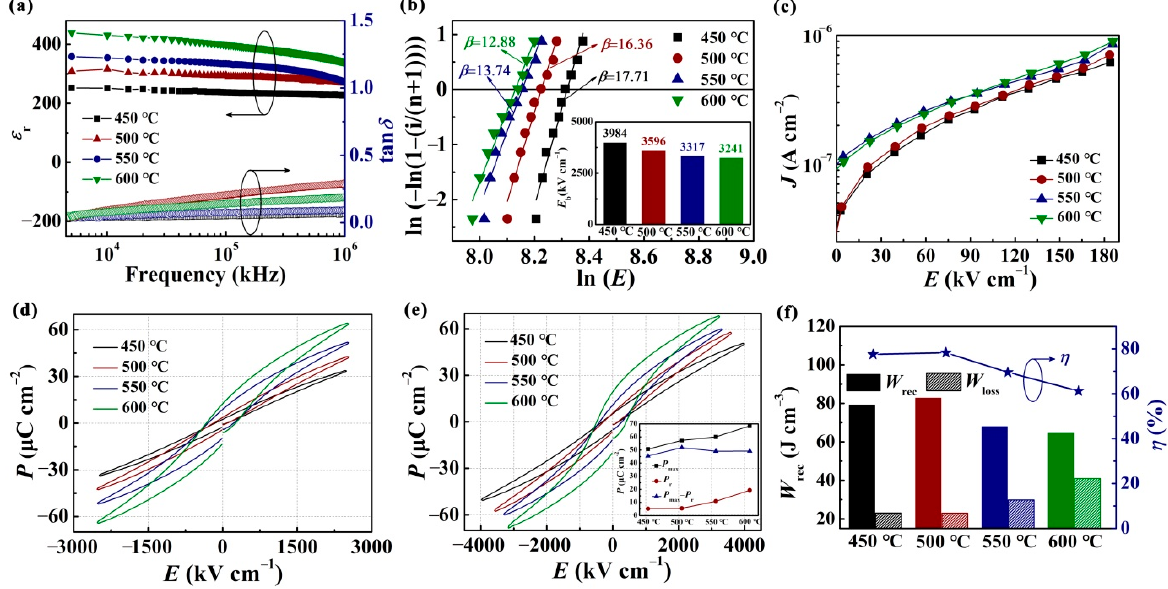
Figure 3. CBTi-BFO films annealed at 450, 500, 550 and 600 °C: ( a ) Frequency dependence of dielectric properties. ( b ) Weibull distributions dielectric breakdown strengths. ( c ) Leakage current density as a function of applied electric filed. ( d ) The bipolar P-E loops at 2500 kV·cm − 1 . ( e ) The bipolar P-E loops around E b , The inset shows the variation of P max , P r , and P max - P r as a function of annealing temperature. ( f ) The variations of W rec , W loss and ƞ values.